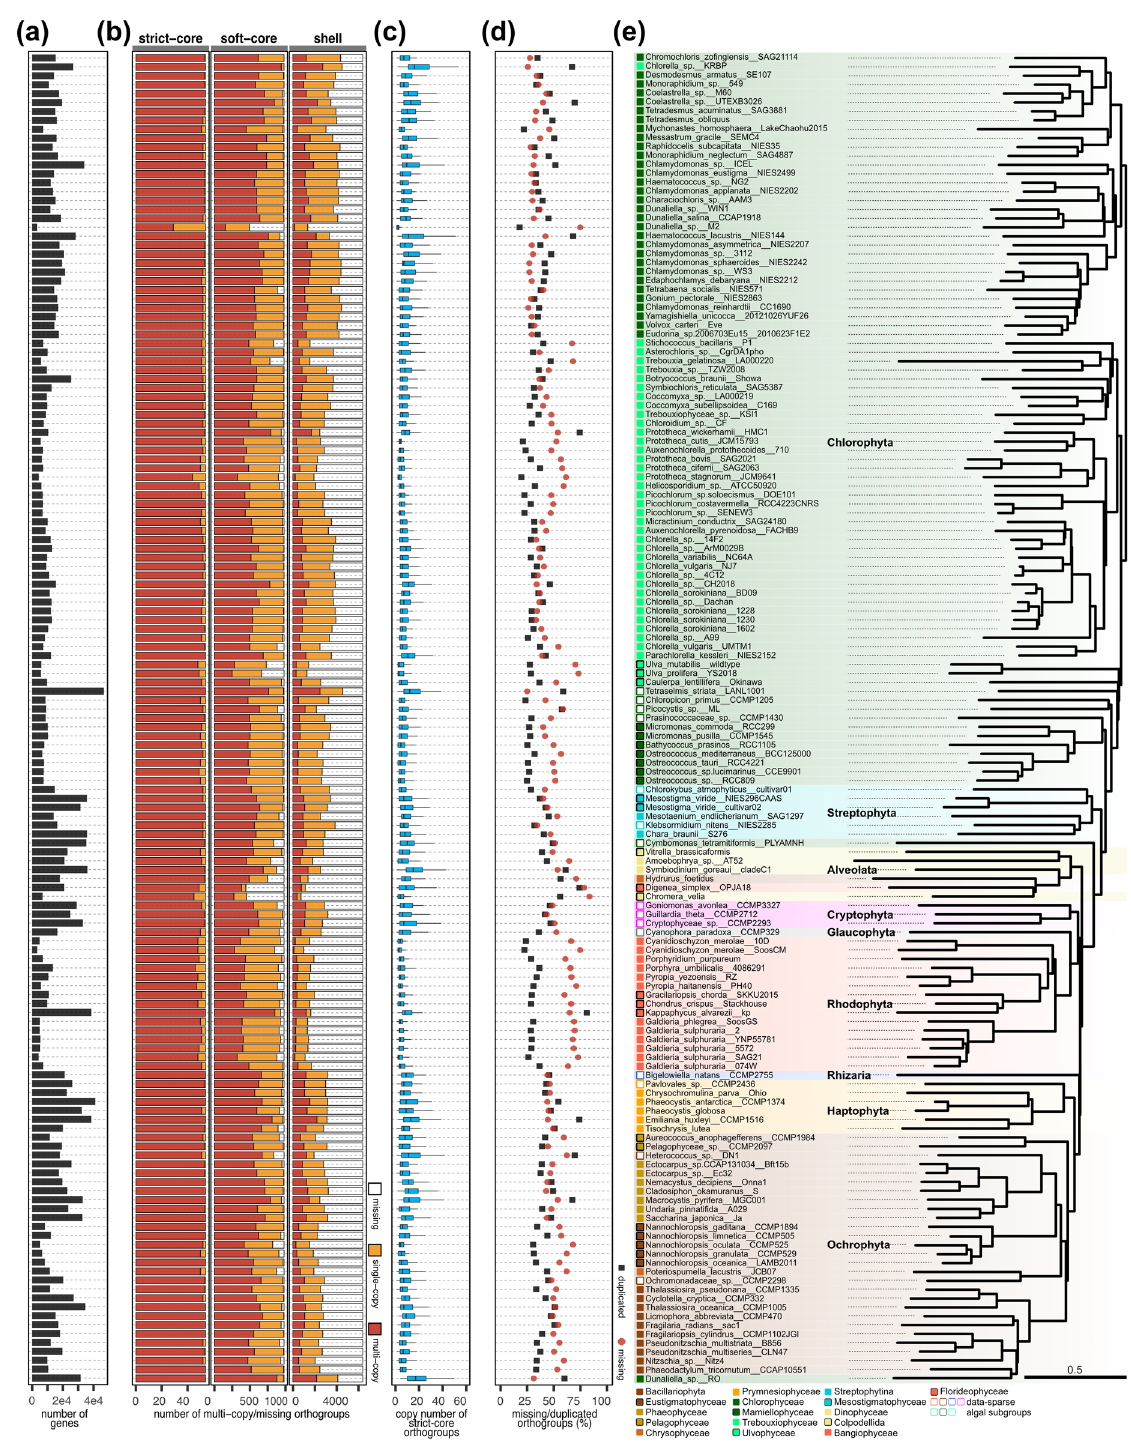
Figure 4. Per-species orthology statistics with STAG phylogenetic tree. ( a ) The number of genes. ( b ) The number of multi-copy, single-copy, and missing OGs across the strict-core, soft-core, and shell OG clusters. ( c ) Boxplot of copy numbers of the strict-core OGs. Outliers were omitted. ( d ) Duplication rates (black) and missing rates (red) calculated in the strict-core, soft-core, and shell OG clusters. Missing rates were calculated with all OGs (n = 7432). Duplication rates were calculated only within the OGs found in each genome. ( e ) STAG tree reconstructed using 54 strict-core OGs. Taxonomic groups are indicated by shaded rectangles. Taxonomic subgroups are indicated by a colored